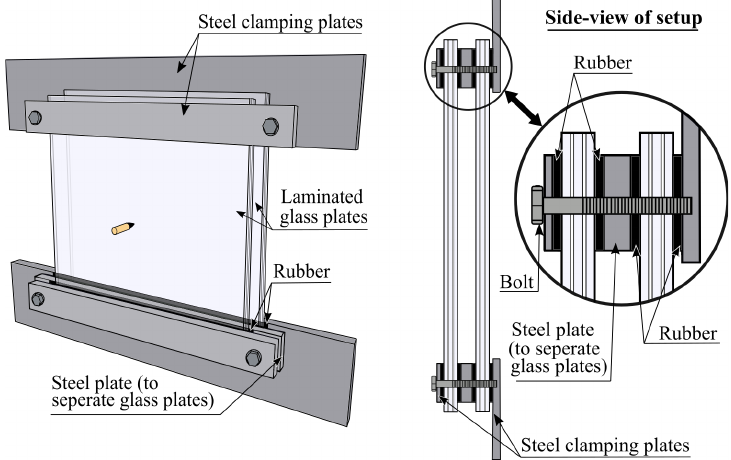
Fig. 1. Sketch of the setup of the DLx2 tests, including a side-view. The same setup is used for DLx1, but with one laminated glass plate.